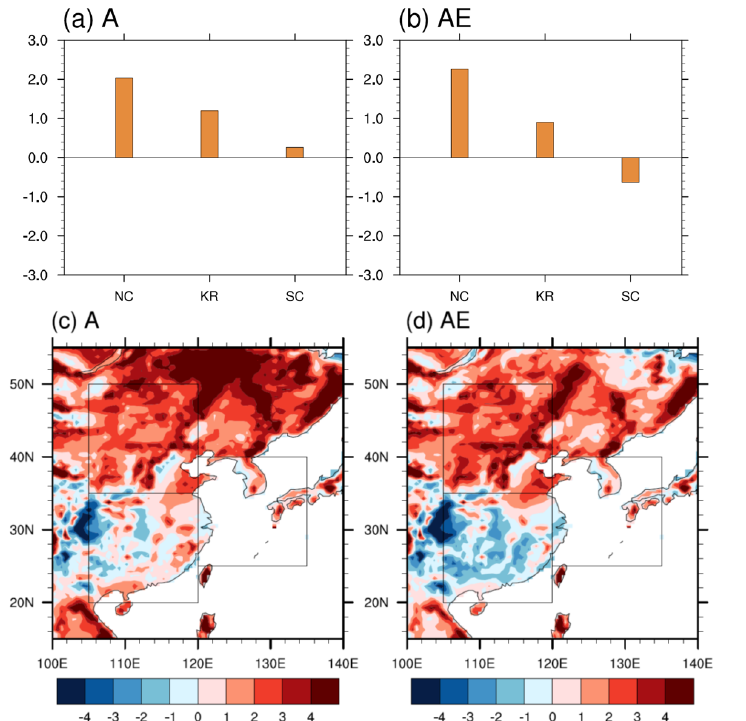
Figure 3. As Fig. 1 but for JJA surface air temperature biases (K) compared to the Climatic Research Unit (CRU)